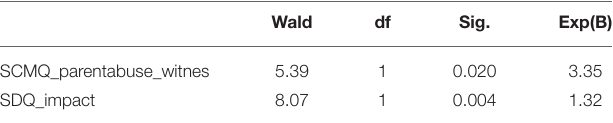
TABLE 6 | Significance of logistic coefficients for PTSD